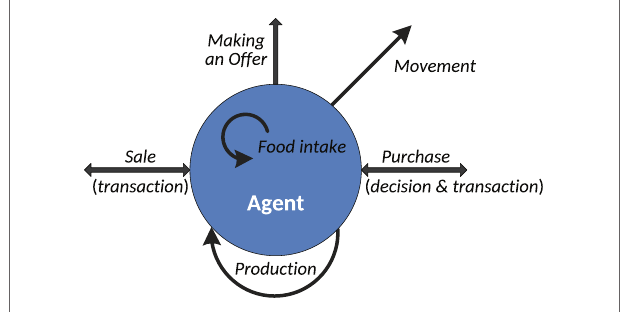
FigUre 5 | agent behaviors . Arrows indicate the direction of action or